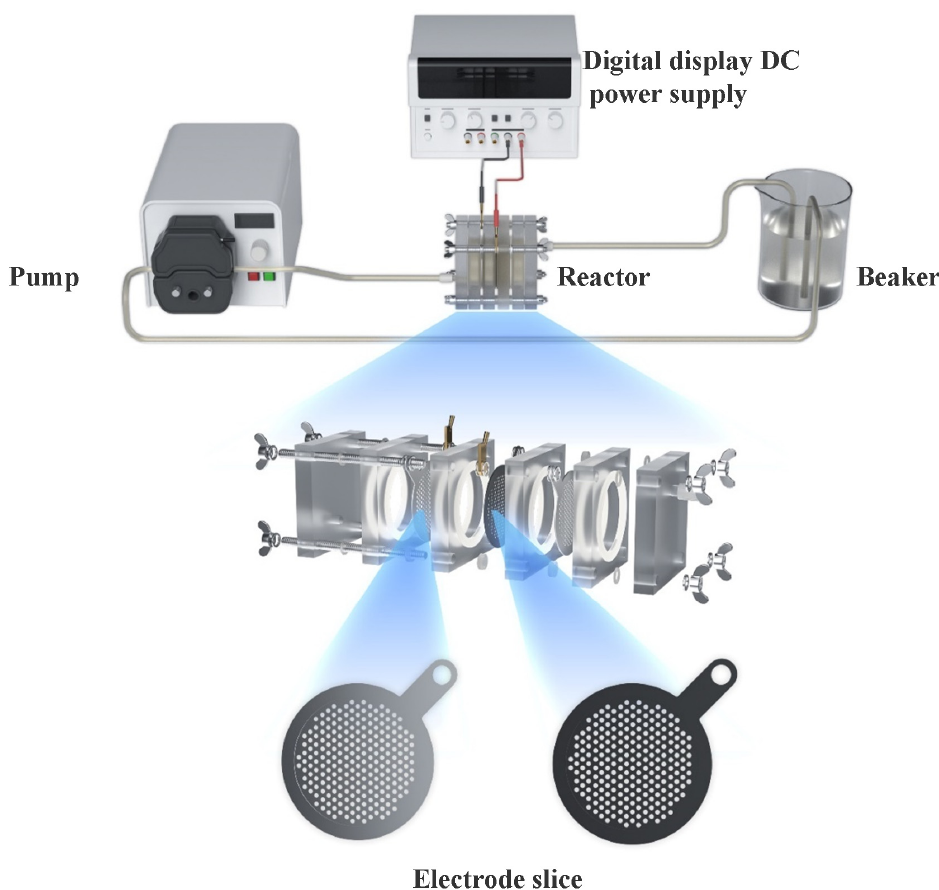
Figure 2. Electrooxidation experimental device.